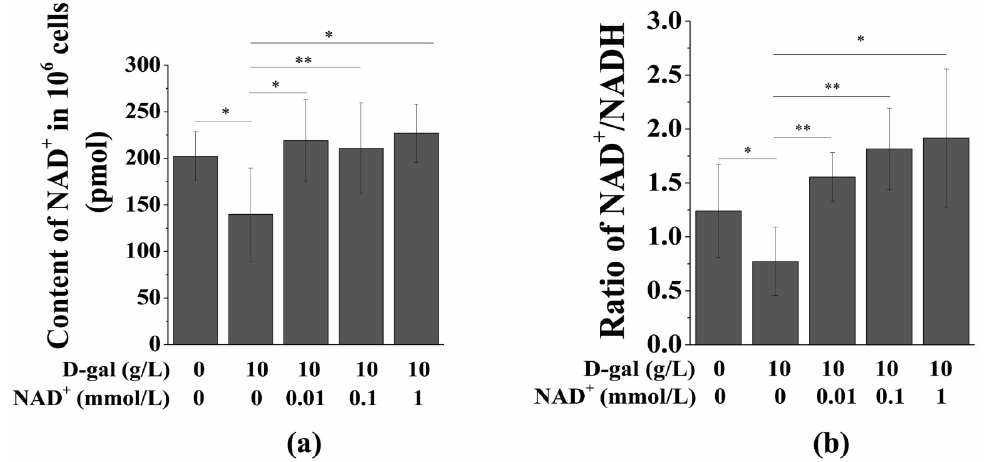
Figure 3. Exogenous NAD + restores NAD + levels in senescent BMSCs. BMSCs were induced by 10 g/L of D ‐ gal for 48 h and then were treated by different concentrations of exogenous NAD + for another 48 h. ( a ) A NAD + /NADH content color ‐ imetric kit was used to detect the changes of NAD + levels in senescent BMSCs. ( b ) Changes of NAD + /NADH in senescent BMSCs determined by the NAD + /NADH content colorimetric kit. The data are expressed as means ± standard deviation. n = 3; * p < 0.05; ** p < 0.01. BMSCs: Bone marrow ‐ derived mesenchymal stem cells; D ‐ gal: D ‐ galactose; NAD + : Nicotinamide adenine dinucleotide.